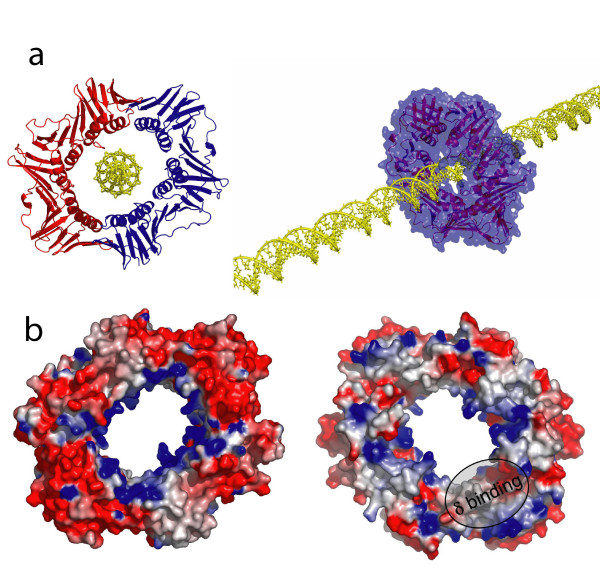
(A) Model of Streptococcus pyogenes β clamp surrounding DNA. (B) Electrostatic surface of S. pyogenes β subunit. Two views of the clamp are shown that differ by a ~180° rotation about the vertical axis. Red indicates regions of negative electrostatic potential, white indicates neutral regions, and blue indicates positive regions. Figure rendered with GRASP [26, 27] and PyMol (DeLano Scientific). The position on the face of the S. pyogenes clamp where the δ subunit of the clamp loader would be expected to bind is indicated based upon the co-crystal structure of the E. coli proteins [18].